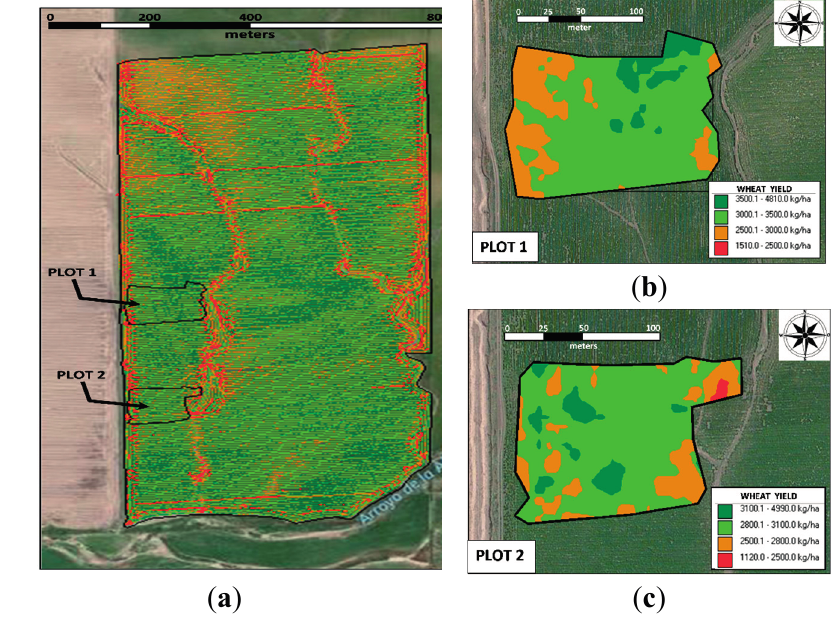
Figure 3. ( a ) Map of the wheat yield and two NDVI sampling sites; ( b ) plot 1 and ( c ) plot